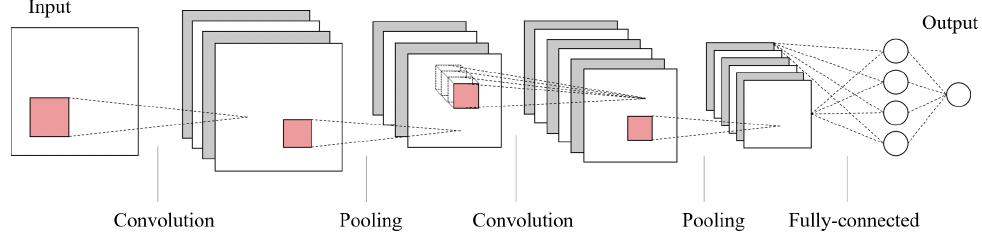
Figure 7. The basic structure of